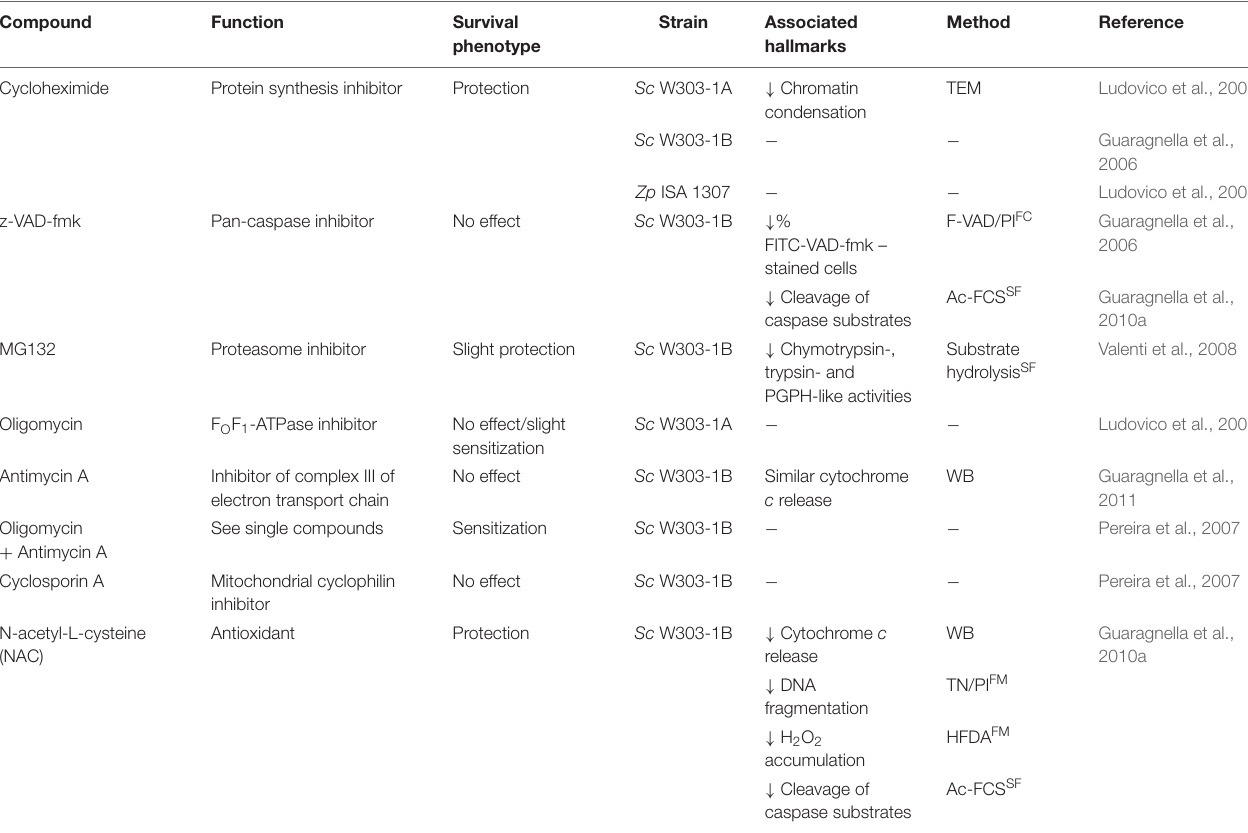
TABLE 1 | Overview of the effect of chemical compounds on AA-RCD.